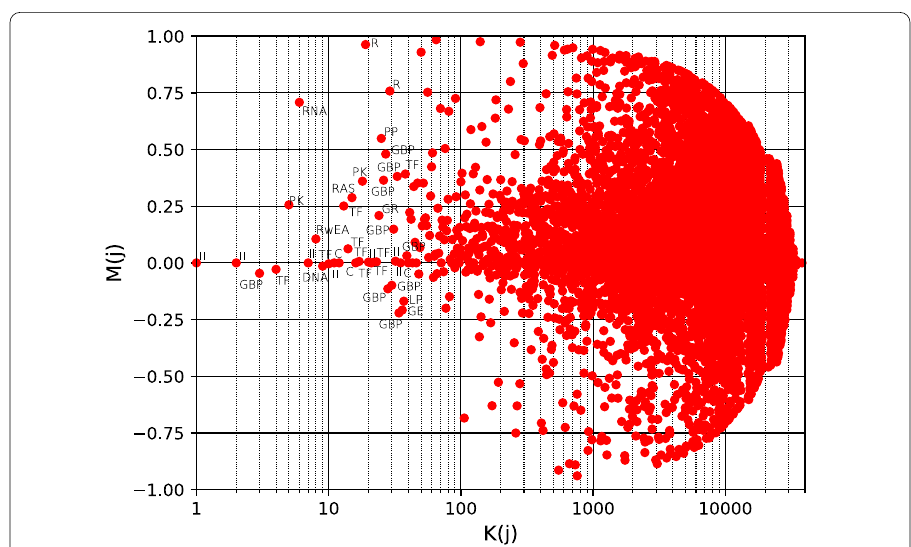
Fig. 3 PageRank magnetization M ( j ) = ( P + ( j ) − P − ( j ))/( P + ( j ) + P − ( j )) for the Ising MetaCore network. Here, j is the node index and K ( j ) is the PageRank index of the node j in the simple Metacore network (without node doubling). The biological class is reported for the top 40 PageRank nodes ( K ≤ 40 , see Table 1): Inorganic ions (II), Generic binding protein (GBP), Transcription factor (TF), Protein kinase (PK), RNA, Receptor with enzyme activity (RwEA), DNA, Compound (C), RAS superfamily (RAS), Reaction (R), Generic receptor (GR), Protein phosphatase (PP), Generic enzyme (GE), Lipid phosphatase